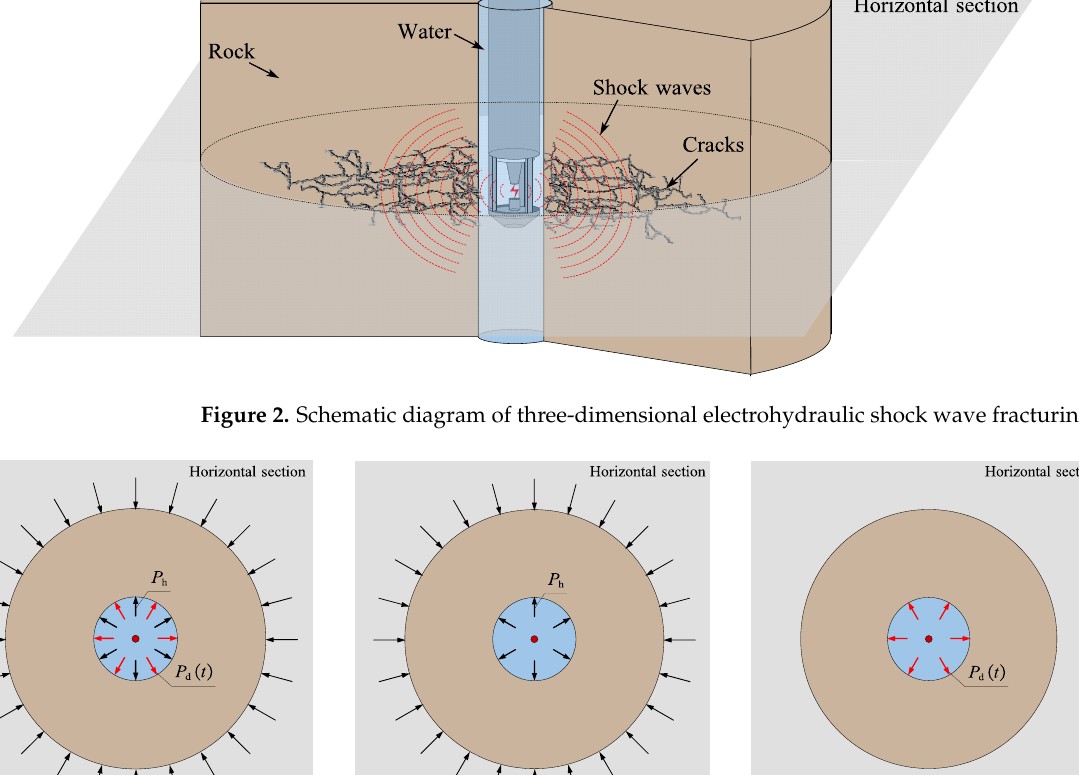
Figure 2. Schematic diagram of three-dimensional electrohydraulic shock wave fracturing.